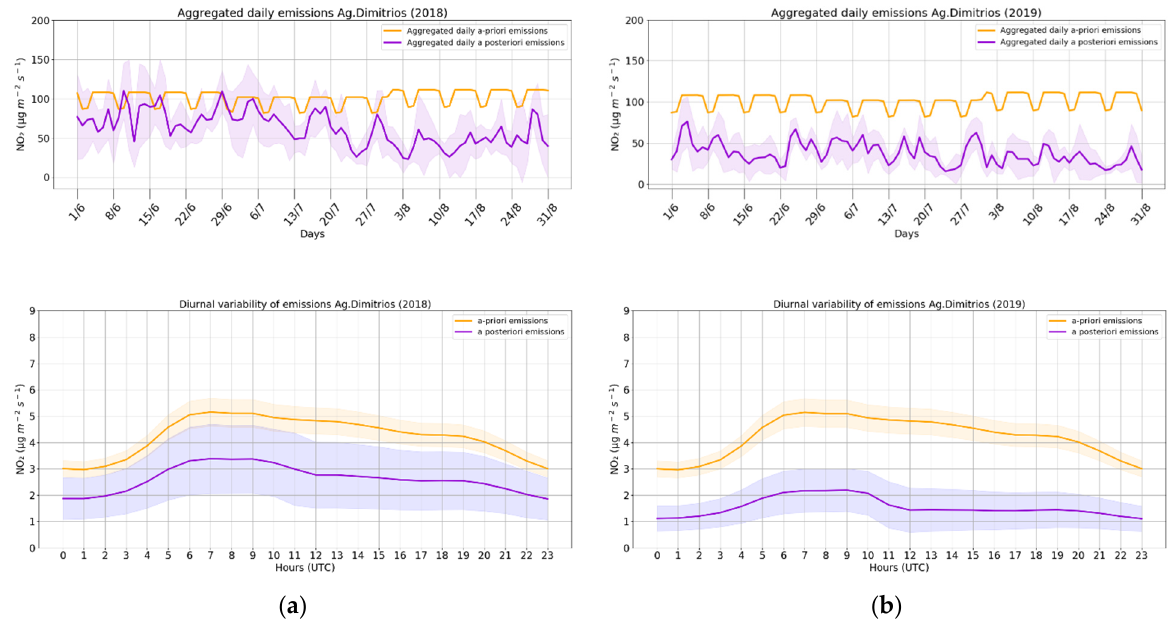
Figure 7. ( Top ): Aggregated daily NO x a priori (orange line) and a posteriori (purple line) emissions and the propagated uncertainty (shaded purple area) derived from S5P/TROPOMI assimilation over the Ag. Dimitrios power plant ( a ) for the summer of 2018 and; ( b ) the summer of 2019. ( Bottom ): Diurnal variability and standard deviation of the same emissions.